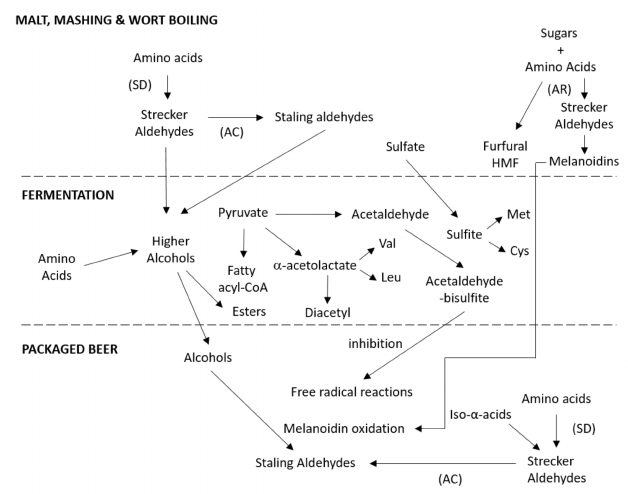
Figure 4. Schematic diagram illustrating the influence of amino acids on the development of flavour active compounds (SD: Strecker degradation, AC: Aldol condensation, AR: Amadori